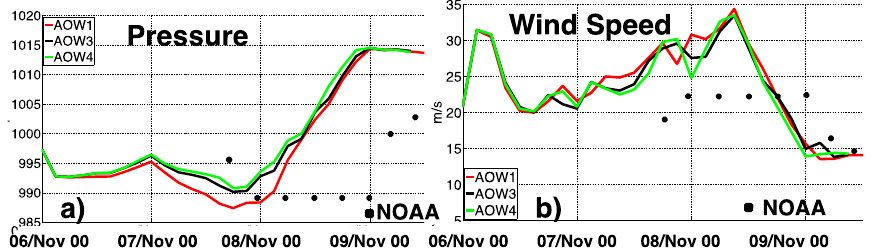
Figure 9. Panel ( a ): time evolution of the pressure minimum (hPa). Panel ( b ): maximum wind intensity (m/s) around the eye, for runs AOW1, AOW3 and AOW4. The black dots refer to the real-time estimation given by NOAA.